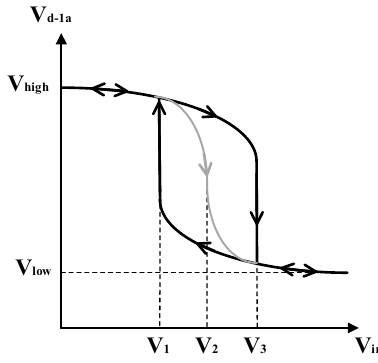
Figure 2. Qualitative hysteresis characteristic of an inverting Schmitt trigger.